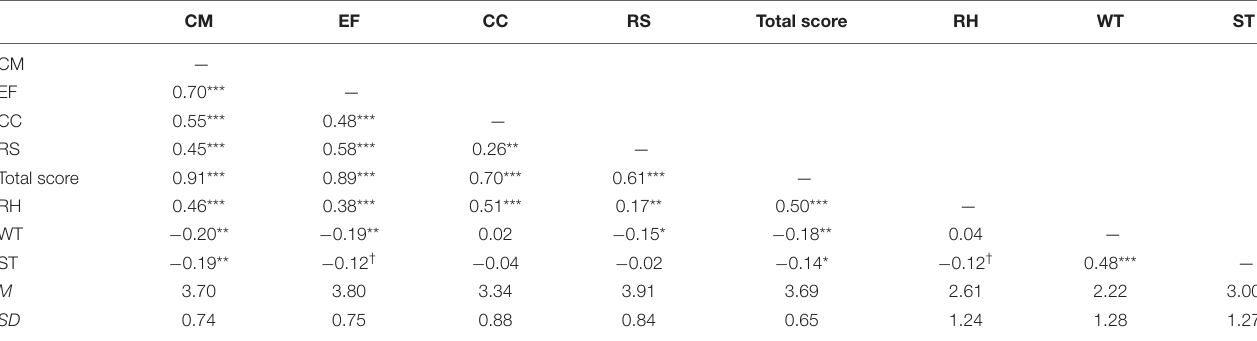
TABLE 8 | Correlation analysis of the total score of and various factors of two-child mothers with the regret of having a second child, the willingness to have a third child and the support for three-child policy ( n = 263). CM EF CC RS Total score